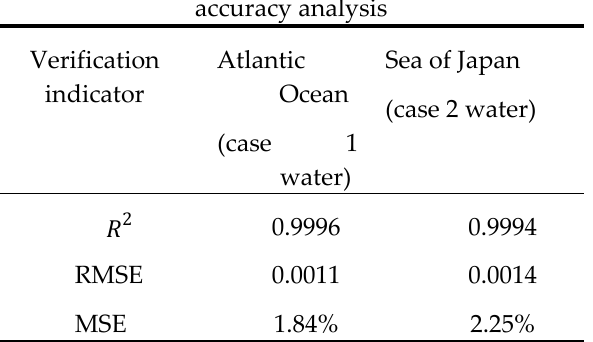
Table 2. QAA_V6 model verification